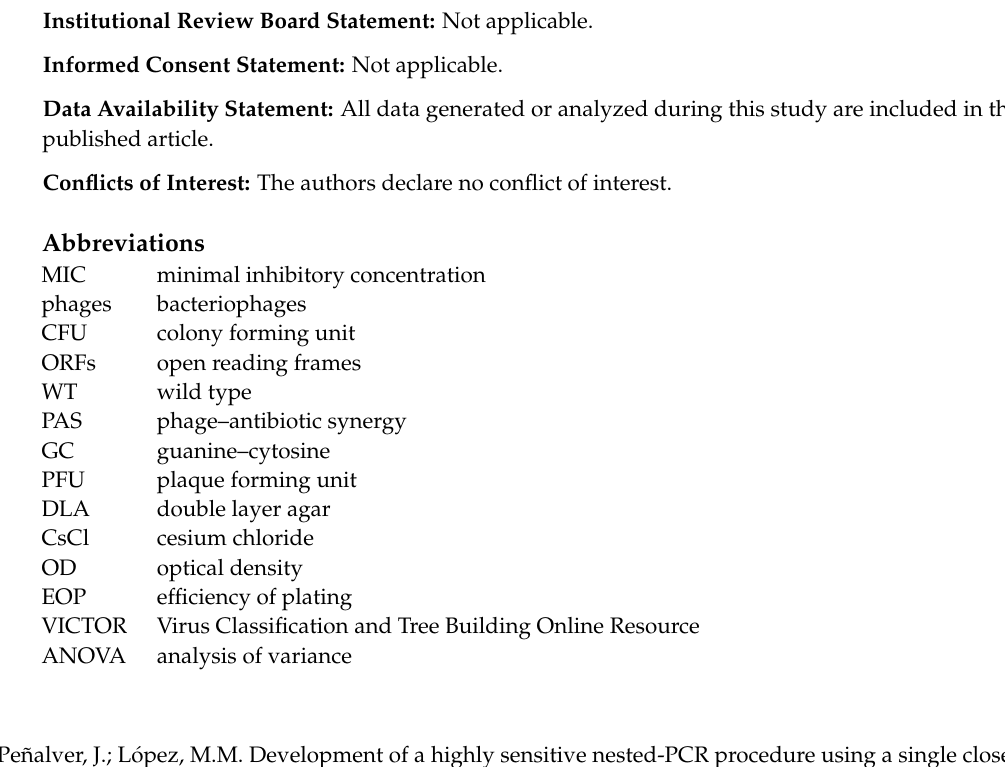
Table S3: Functional classification of ORFs in Erwinia phage pEa_SNUABM_31, Table S4: Functional classification of ORFs in Erwinia phage pEa_SNUABM_32, Table S5: Functional classification of ORFs in Erwinia phage pEa_SNUABM_47, Table S6: Functional classification of ORFs in Erwinia phage